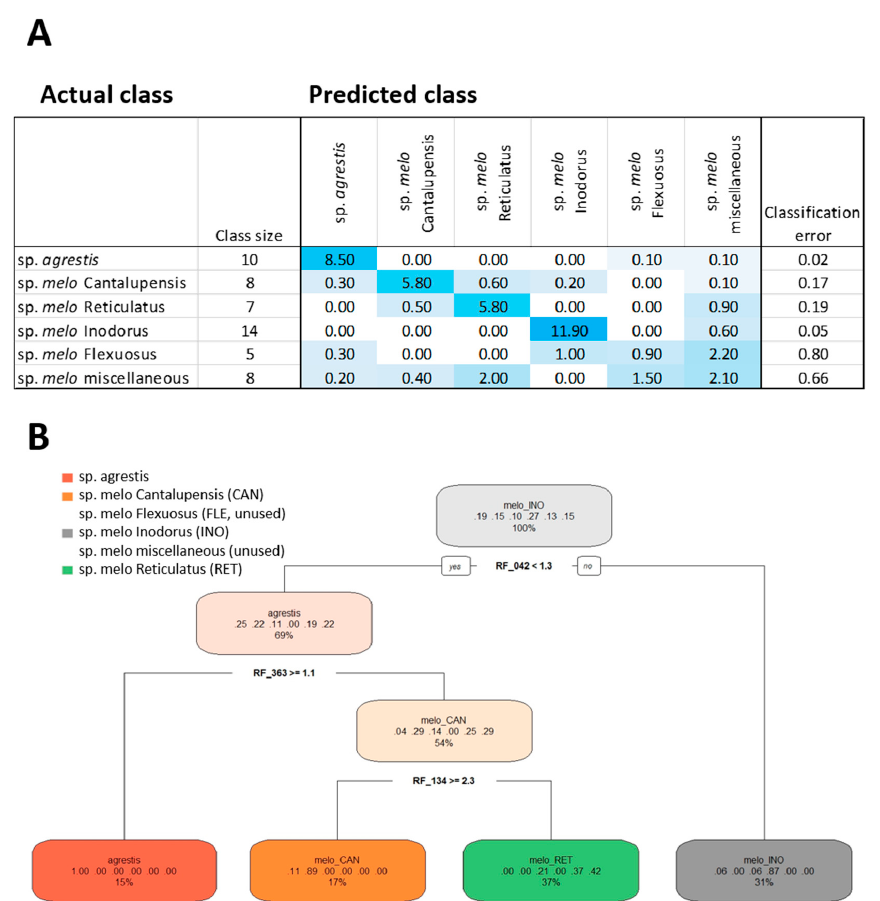
Figure 4. Random forest (RF) analysis ( A ) and decision tree classification ( B ) of six C. melo accession classes using a subset of 605 provisionally annotated molecular features. Classification of six pre-defined melon accession classes was performed. The classification table (A) lists classes, class size, the actual and predicted class membership, and the classification error (means of 10 iterations using hyperparameter-tuned RF settings). The decision tree uses the top 20 most informative molecular features ranked by the mean decrease in accuracy. The node information of the decision tree reports the used molecular feature code (Table S4) and threshold value. The branch information (colored ovals) lists the main class, the fraction of classified samples, left to right, subsp. agrestis , Cantalupensis, Flexuosus, Inodorus, miscellaneous, and Reticulatus accessions of subsp. melo . The percentage value indicates the fraction of the 52 accession samples that fall into each of the diagnostic categories.